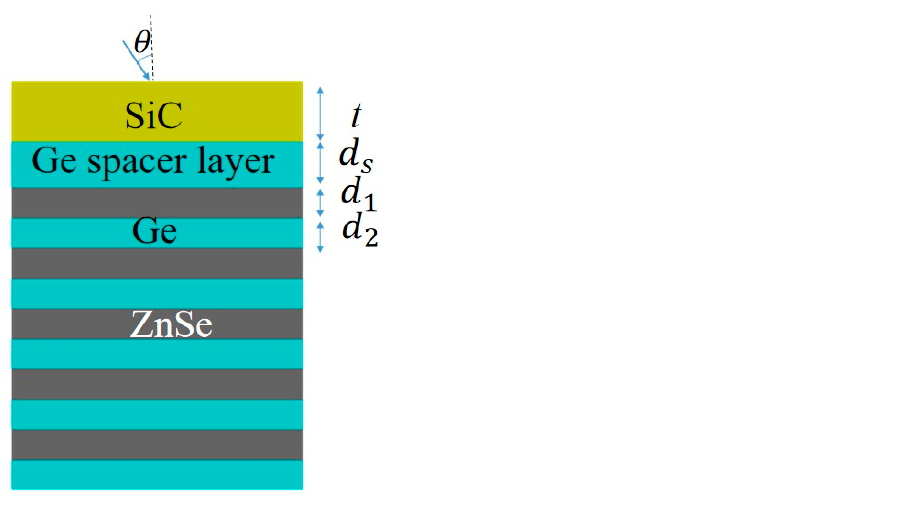
Figure 1. Cross-section view of the thermal emitter based on SiC film with DBR reflector. Polar dielectrics can stimulate surface phonon polaritons (SPhPs) mode, which is the result of coupling between the surface electromagnetic modes (photons) and the lattice vibrational modes (optical phonons) of polar materials. SPhPs is formed on the surface of polar dielectrics and inherently exhibit longer scattering lifetimes than SPPs, resulting in lower optical losses. The real part of the dielectric function of the SiC is negative within the Restsrahlen range [27,28]. The wavelength-relative dielectric constant of the SiC can be represented in the terms of the Drude − Lorentz model [29,30].